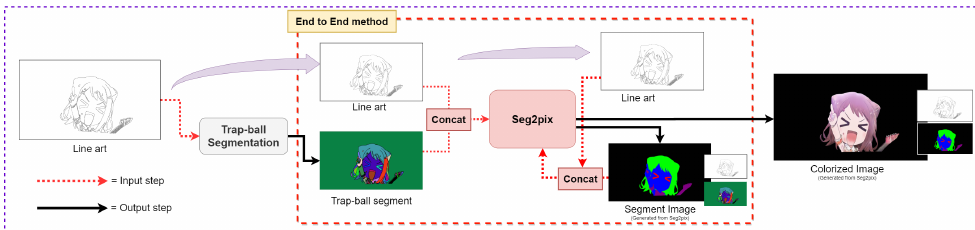
Figure 3. Seg2pixgenerates the output by two concatenated image data. The first step generates the “segmented image” by the line art and trap ball segment input; the second step generates the “colorized image” by the line art and segmented image. This generation works by an end-to-end method updating the same loss function data (sample image from ©Bushiroad Co., Ltd.)